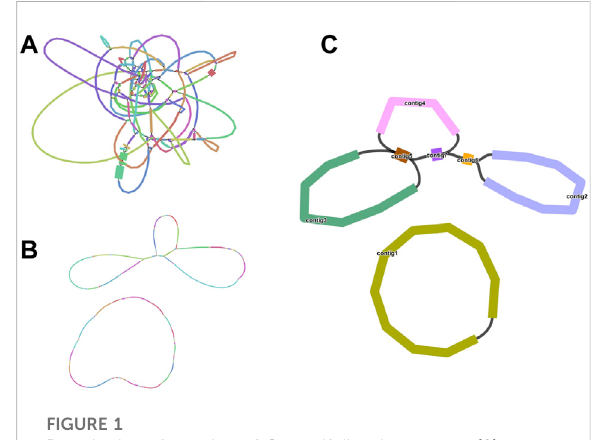
FIGURE 1 Branched conformation of C. acerifolia mitogenome. (A) : Sketch of the mitogenome of C. acerifolia , containing 136 nodes. (B) :The mitogenome sketchobtained after selectingthe best path supported by the long read data of ONT and resolving the individual repeat regions. (C) : Mitogenome mapping of C. acerifolia , with circular DNA molecules comprising contig1 and linear DNA molecules consisting of contig2, contig3, contig4, contig5, contig6 and